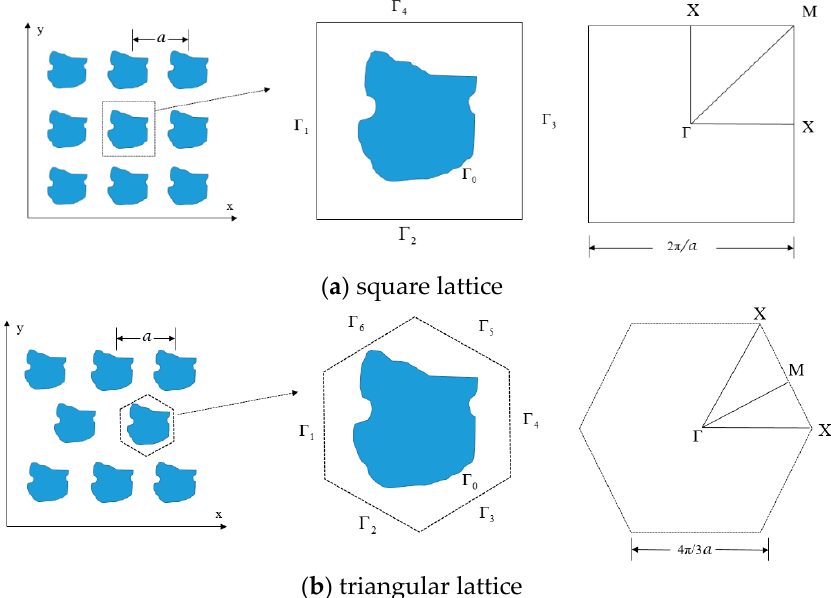
Figure 1. A perfectly phononic crystal with infinite periodic structure of ( a ) square lattice and ( b ) triangular lattice with their unit cells and first Brillouin zones.